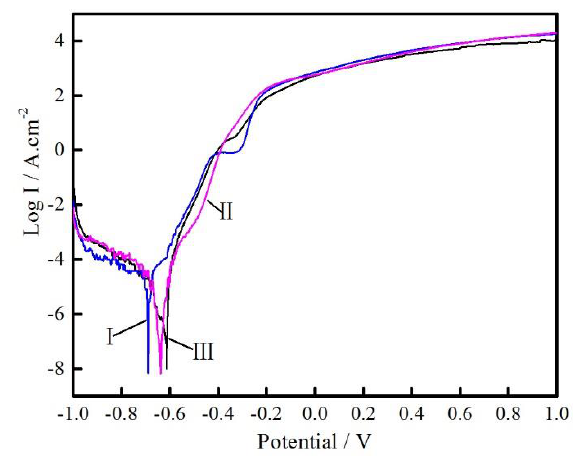
Figure 7. Polarization curves of specimens: I (CC 0.2 m/min), II (CC 0.3 m/min), and III (PC 0.2